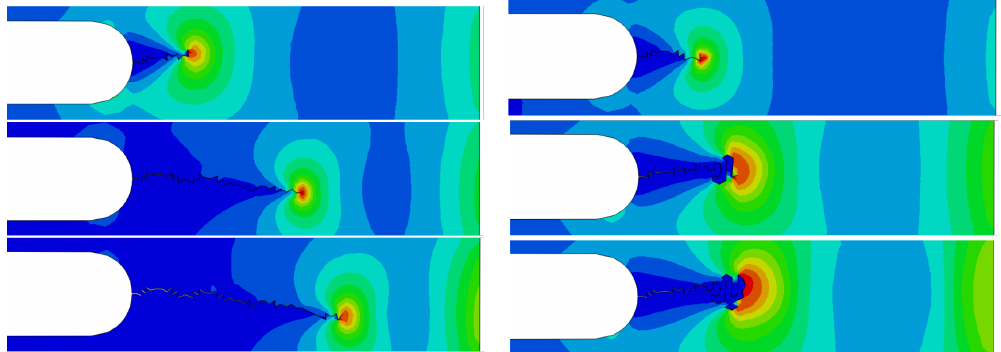
Figure 12. Simulation of crack growth after 100 iterations. Left column depicts the crack evolution at F a = 2 kN and right at F a = 10 kN. The colors display the Von Misses stress to contrast the crack